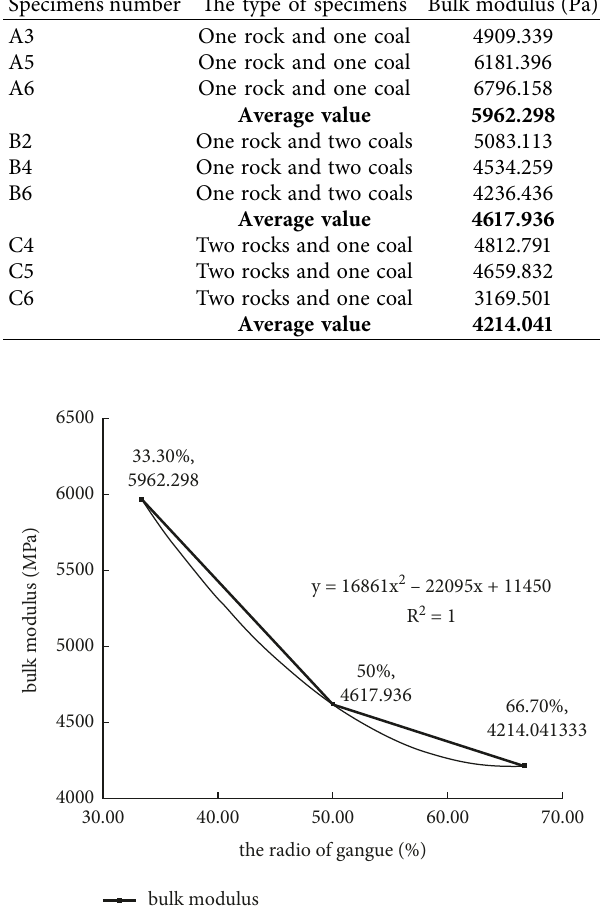
Figure 7: The relationship between gangue ratio and bulk